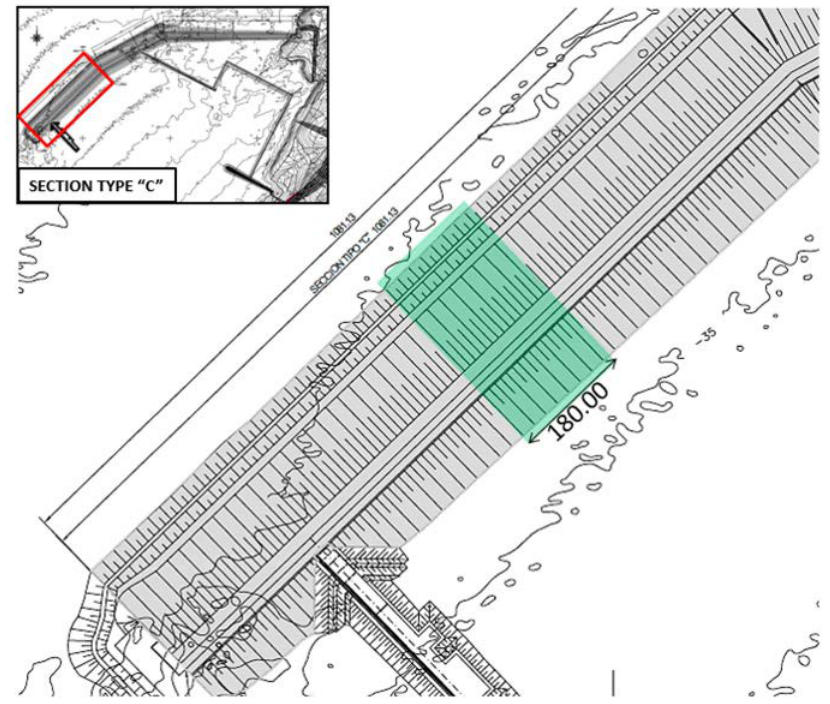
Figure 4. Plan of Section C of the main breakwater of the Outer Port of A Coruña (Langosteira).